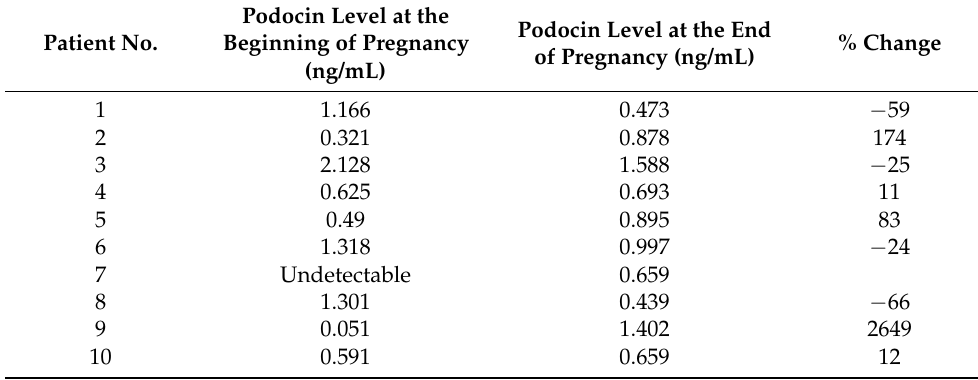
7 Undetectable 0.659